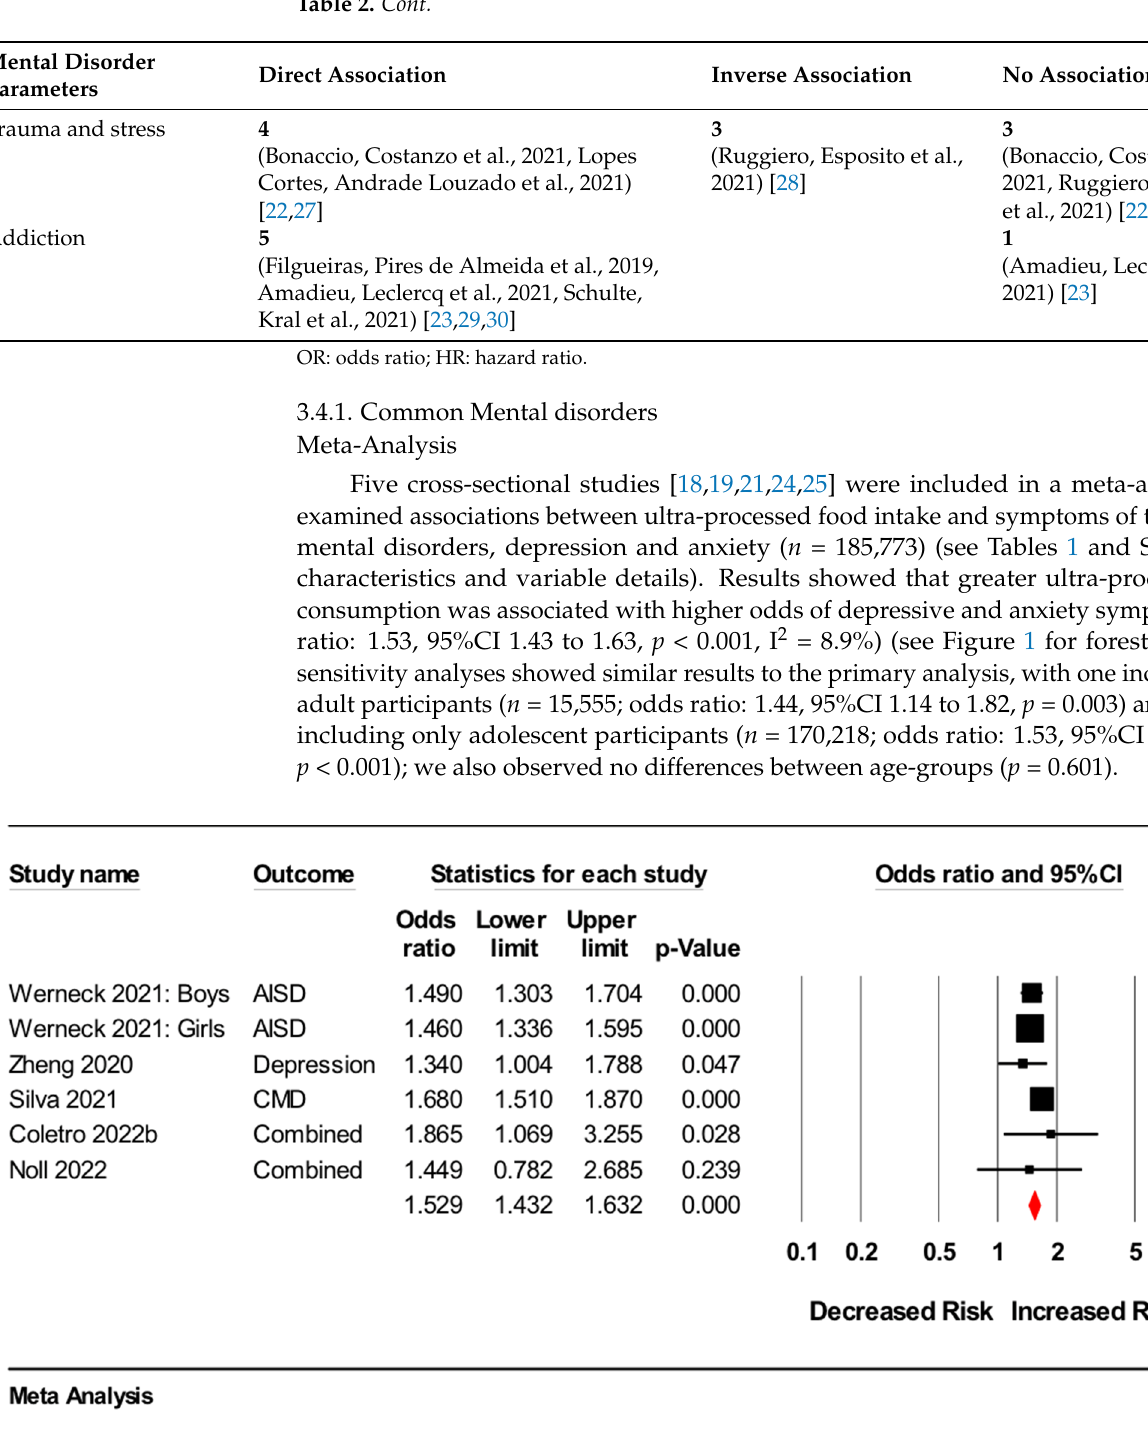
Figure 1. Forest plot of meta-analysis for cross-sectional studies assessing association between higher versus lower consumption of ultra-processed food and odds of common mental disorder symptoms. Note: AISD: anxiety-induced sleep disturbance; CMD: common mental disorders. For ‘Coletro 2022b’ and ‘Noll 2022 ′ , effect estimates for depressive and anxiety symptoms were combined [18,19,21,24,25].